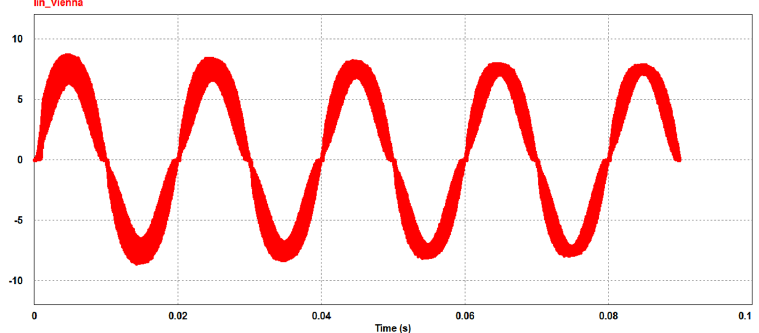
Figure 18. Input current waveform of an IH system with the MVR.